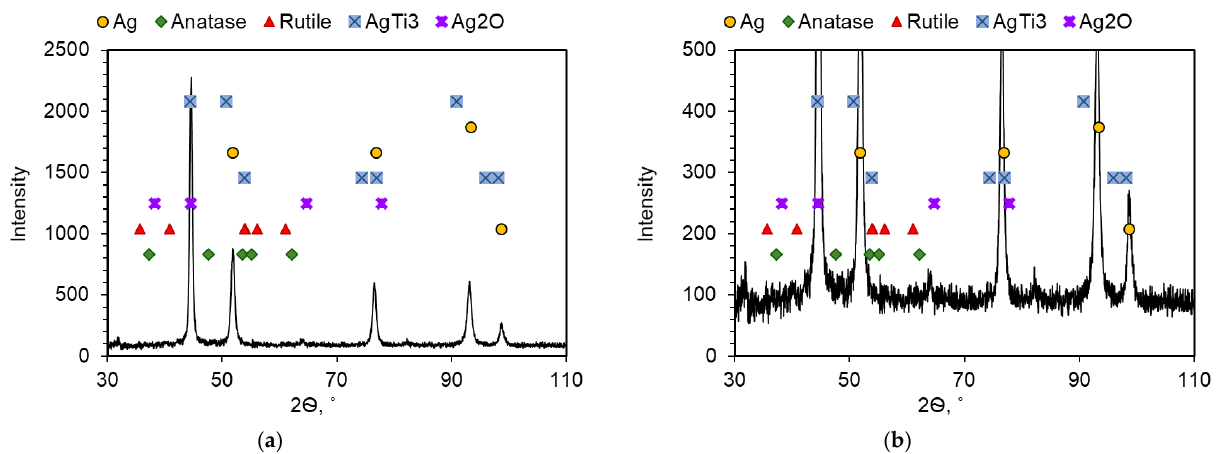
Figure 7. XRD analysis of Ag–5wt% TiO 2 composites; ( a ) in range of intensity 0–2500; ( b ) in range of intensity 0–500.